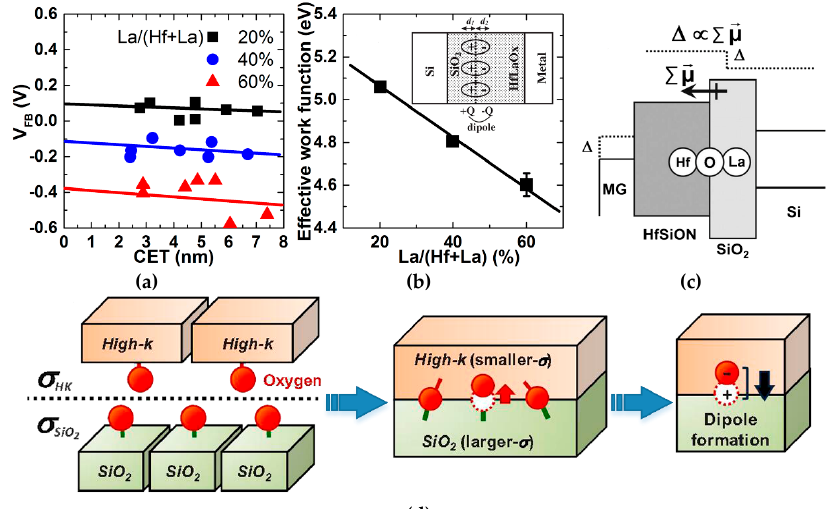
Figure 12. ( a ) V FB and ( b ) effective work function of Au/HfLaO x /SiO 2 /p-Si capacitors with different La concentrations in the dielectric [71,72], ( c ) interface dipole moment model [73], and ( d ) schematic diagram for the formation of the interface dipole [74].